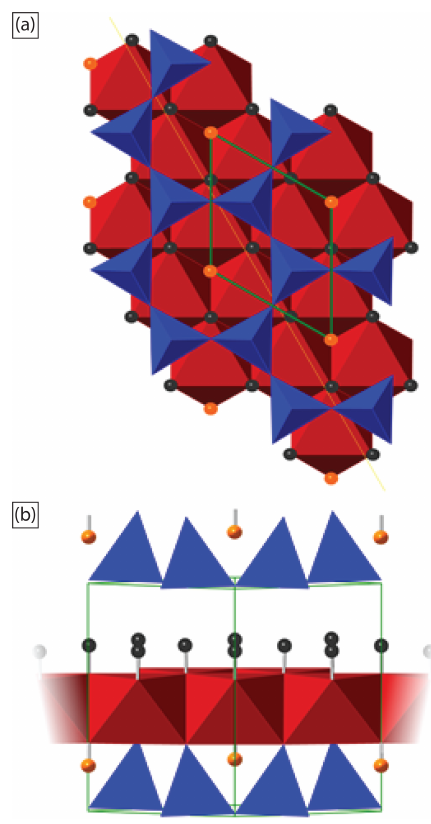
Figure 9. The crystal structure of lizardite (Rooney et al., 2018). (a) Viewed from a silicate tetrahedral sheet looking down to the adjacent octahedral sheet, direction [ 001]. The crystal cell is shown in green, while the corners of the tetrahedra and octahedra represent oxygen atoms. The hydrogen atoms of the outer hydroxyl groups are shown in black, and the hydrogens of the inner hydroxyl groups are shown in orange. (b) The crystal structure viewed along [110] which is shown in (a) as the yellow